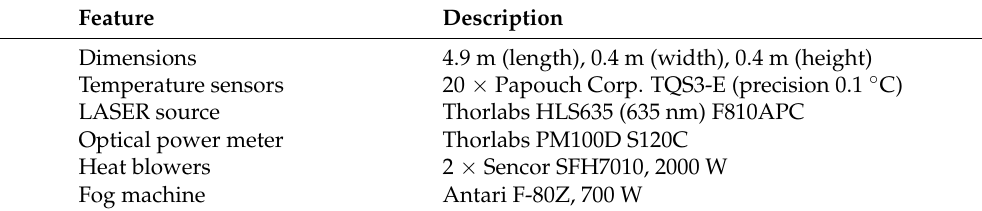
Table 3. Laboratory chamber parameters and